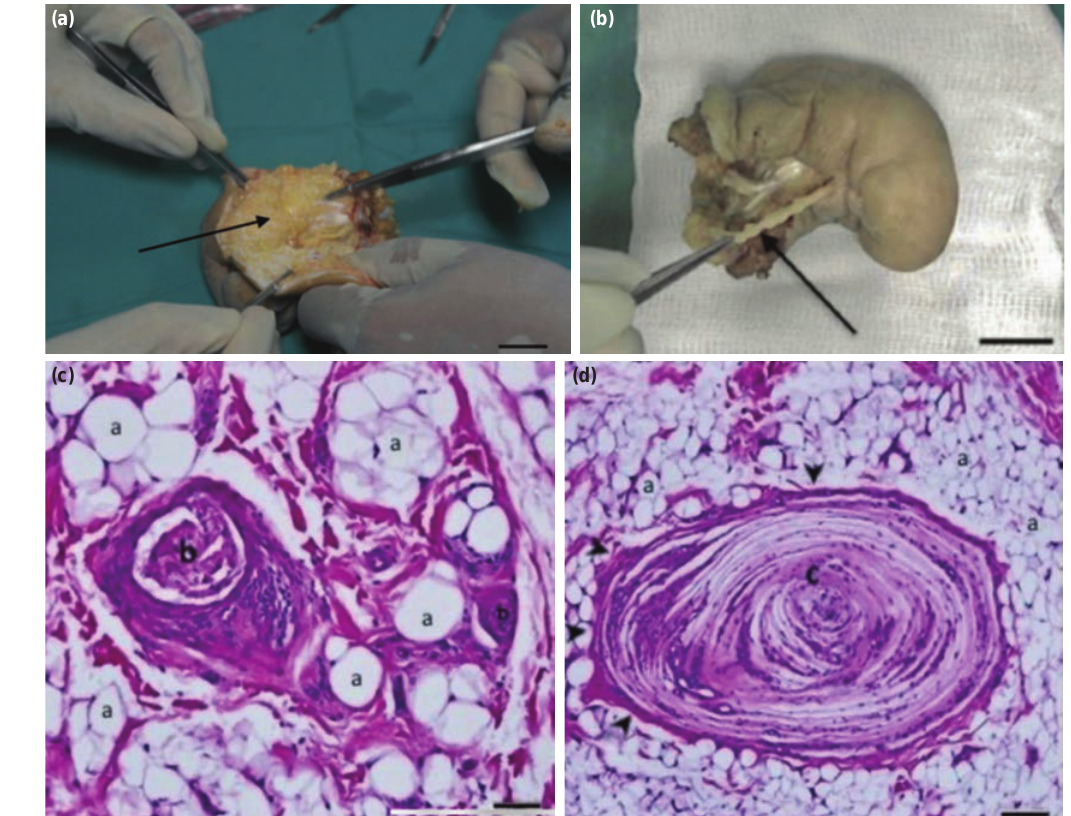
Anatomical dissection and histological examination. (a) Anatomical dissection of the left 2nd toe showing excess subcutaneous tissue (arrow) deep to the skin. Bar = 2cm. (b) Enlarged nerve (arrow) accompanying the overgrown toe. Bar = 2cm. (c) Histological examination showed expansion of the epineurium and perineurium by adipose tissue and separation of individual nerve bundles. a = adipose tissue, b = nerve bundle (H&E stain, Bar = 1mm at x40 magnification). (d) There is concentric perineural fibrosis (arrowhead) and pseudo-onion bulb formation. a = adipose tissue, c = nerve fascicle (H&E stain, Bar = 1 mm at x40